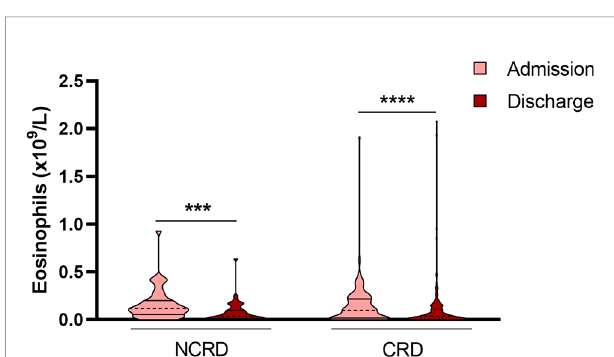
FIGURE 2 | Patients at discharge show a lower number of blood eosinophils. Data revealed that eosinophils were higher on admission than at discharge in both groups (CRD and NCRD). Patients treated with systemic corticosteroids during hospitalization were excluded from analysis. *** p < 0.001; **** p <